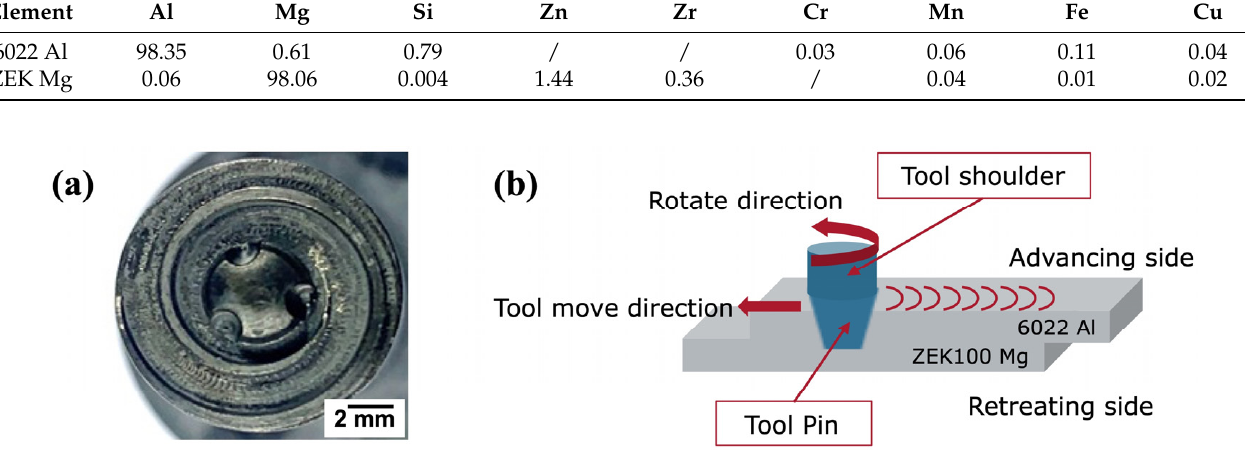
Figure 1. ( a ) Image of the tri-flute pin with the scrolled shoulder; ( b ) schematic of friction stir lap welding (FSLW) Al-Mg joint. Table 1. Chemical composition of AA 6022 Al and ZEK 100 Mg (wt.%).